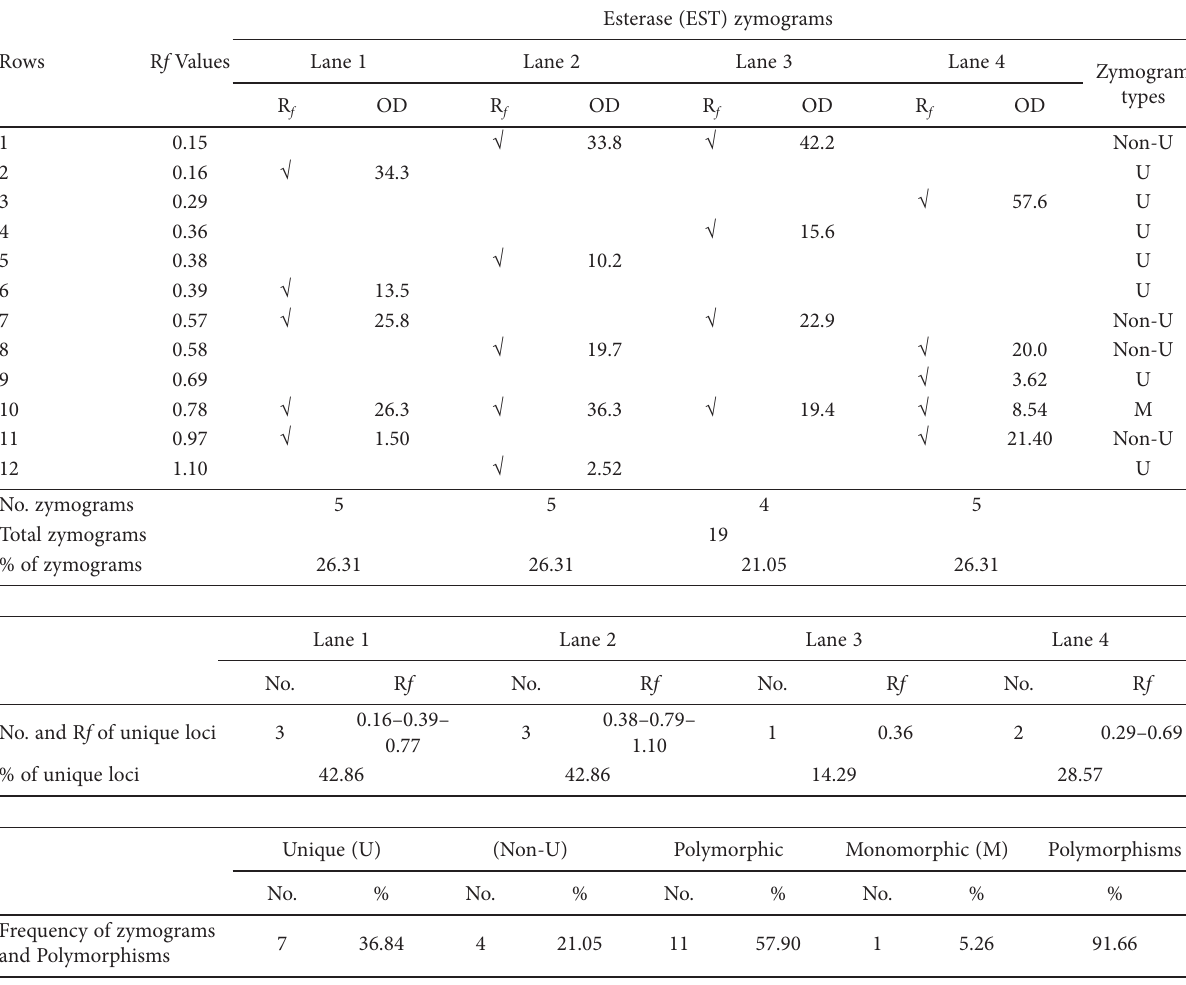
Table 3. Distribution of esterase (EST) zymograms of EMF non-exposed and exposed Zea mays seedlings for days of exposure times (Ex-0, Ex-1, Ex-3, and Ex-5) based on relative front (R f ) Values and optical densities (OD). Lanes 1–4 represented the days of exposure times (Ex- 0, Ex-1, Ex-3, and Ex-5), respectively.